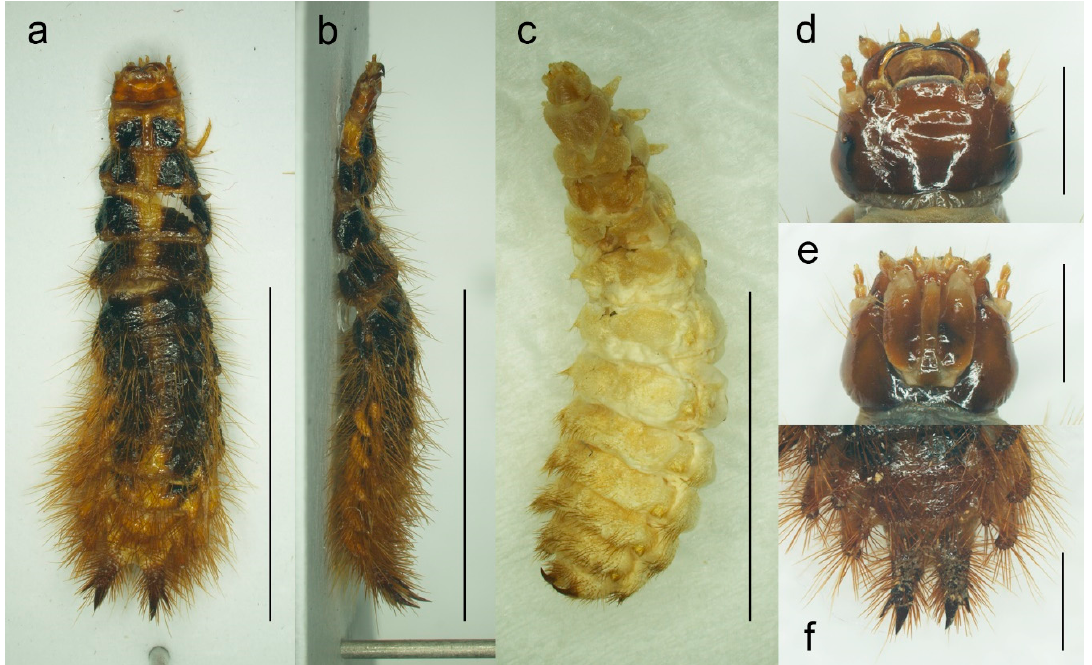
Figure 7. Malacogaster sp. from Morocco (PCRK), larval morphology. ( a ) Active larva, habitus, dorsal view; ( b ) active larva, habitus, lateral view; ( c ) pseudopupa, habitus, dorsal view; ( d ) active larva, head, dorsal view; ( e ) active larva, head, ventral view; ( f ) active larva, apex of abdomen, dorsal view. Scale bars = ( a – c ) 8.0 mm; ( d , e ) 1.0 mm; ( f ) 1.50